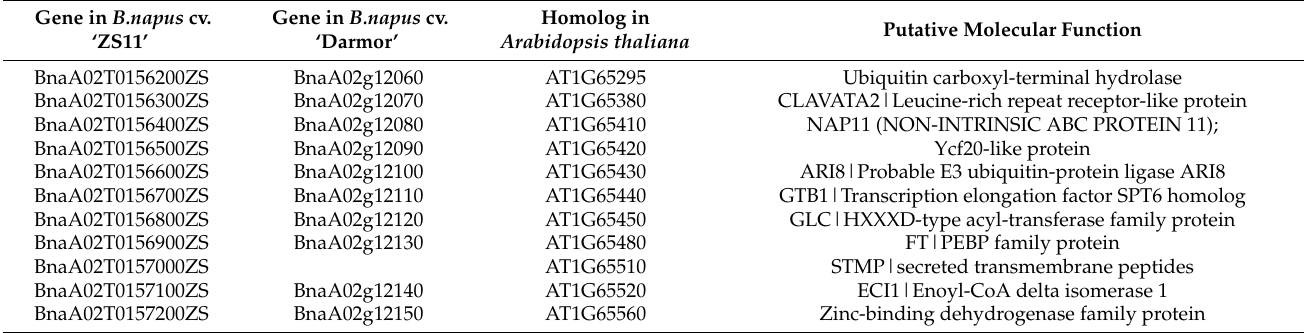
Table 5. Function annotation of genes in the mapping interval. Gene in B.napus cv.